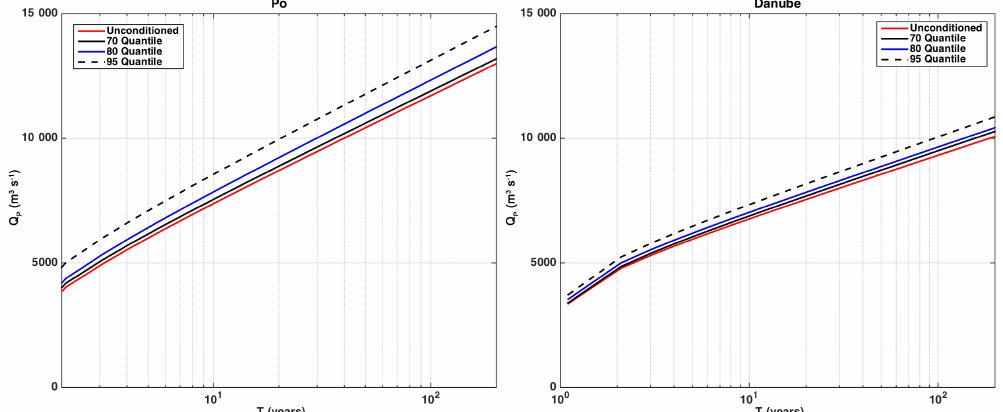
Figure 7. Peak flows in the flood season (October–November in the Po, May–July in the upper Danube) vs. the return period modeled through the EV1 distribution function. Quantiles refer to mean flows higher than usual in the previous month.